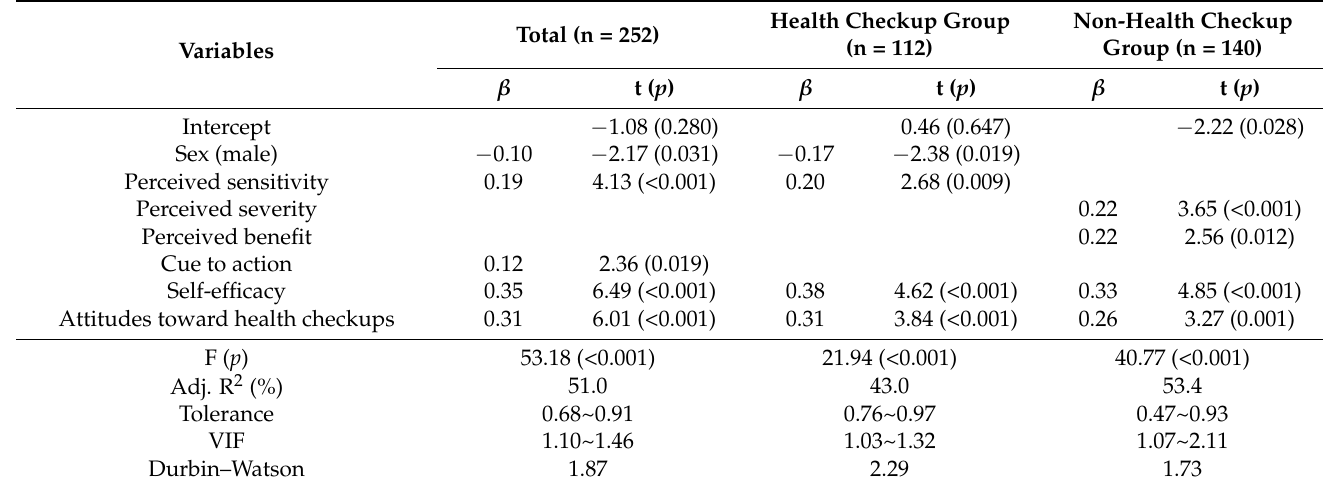
Table 5. Influencing factors on intentions to health checkups (n =